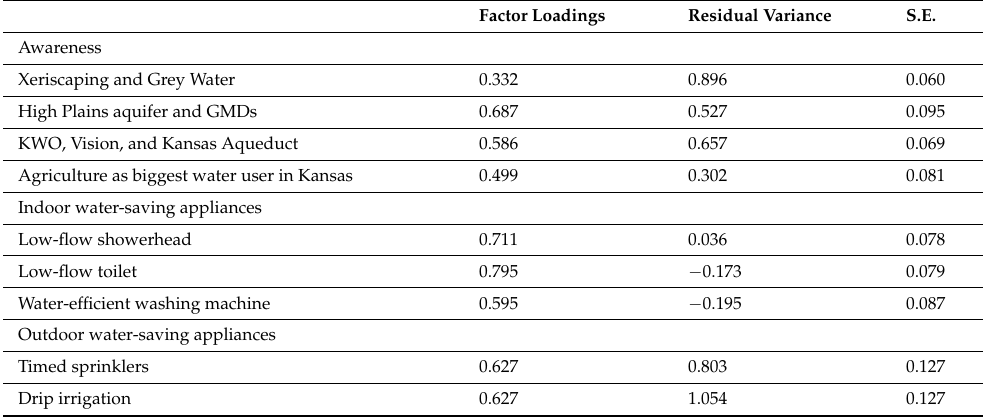
Table A6. Standardized model results of owning water-saving appliances for appliances for indoor and outdoor usage regressed on awareness levels for domestic well owners (n = 145).